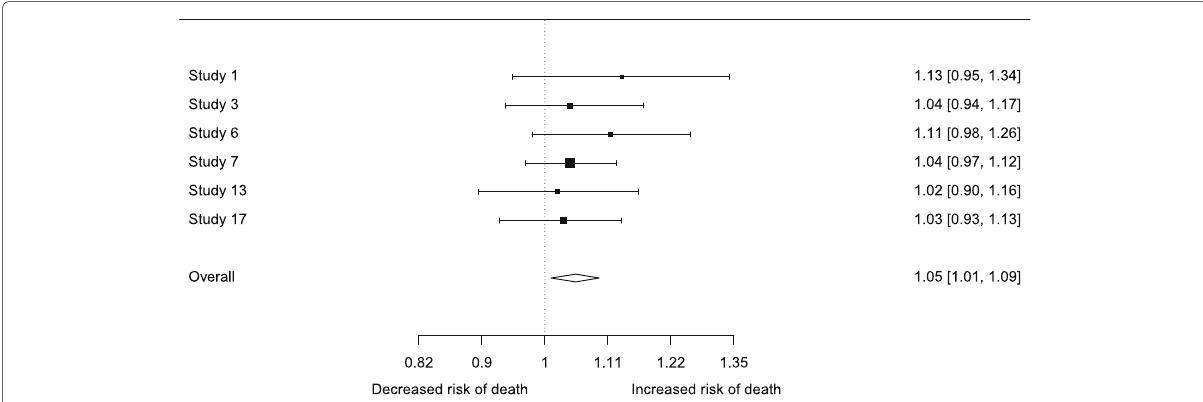
Fig. 2 Meta-analysis of multivariable predictor effects. Association between risk of death and increase of one microvessel count, as measured by the Chalkley method. Estimates represent multivariable hazard ratios, adjusted for age and cancer stage